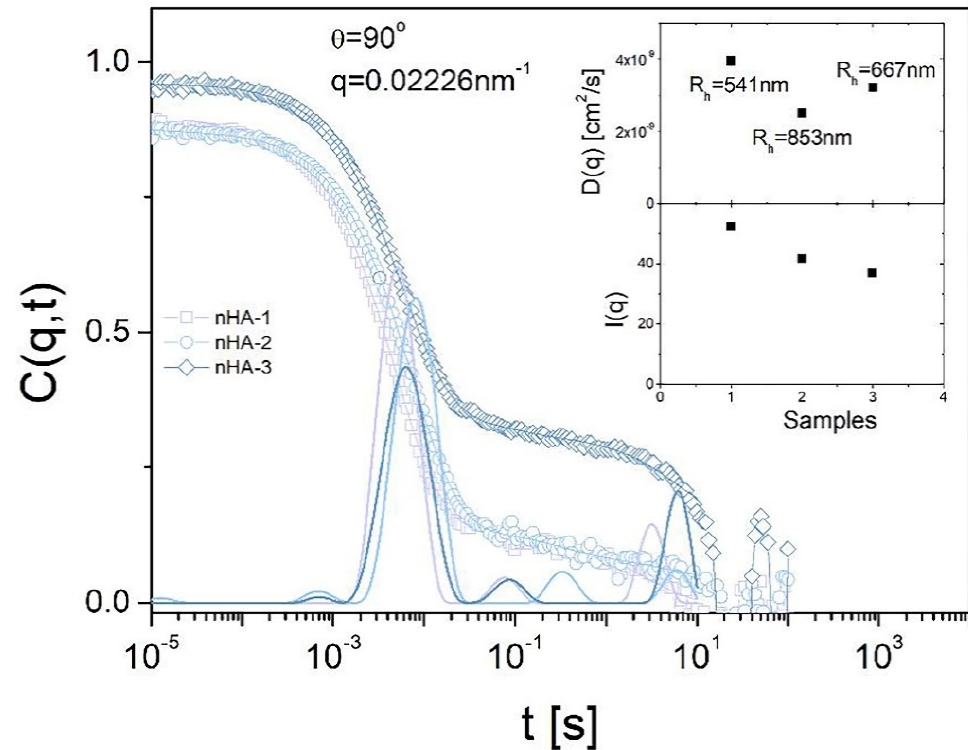
Figure 5. Dynamic light scattering analysis of the three samples nHA-1, -2 and -3 to determine particles hydrodynamic radius R h of the three nHA samples measured in high dilutions of parts per million in deionized water at 90° angle. The standard deviation of the diffusion coefficient is approximately 1.6% and the error of the analysis for the main process is approximately 5%.